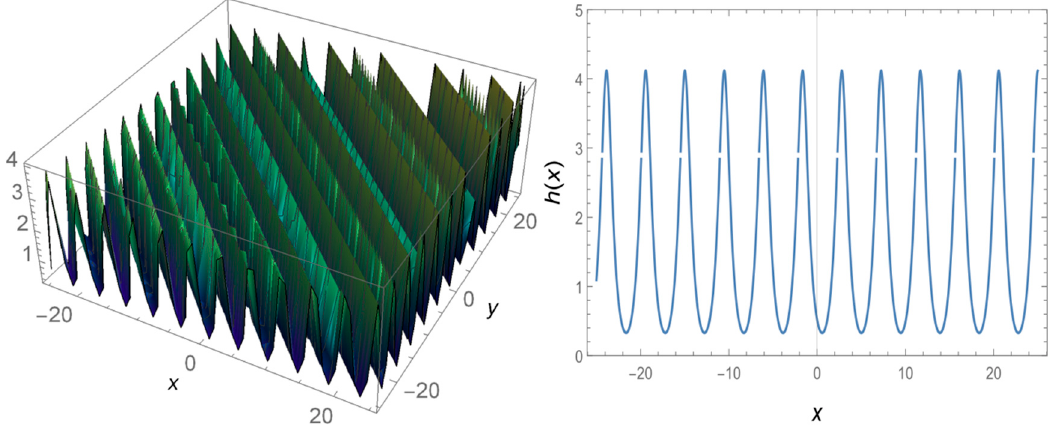
Figure 4. Three-dimensional and 2D graphs for values t = 2, θ 0 = 1, λ = 3, m = 2, µ = 0.5, d = 1, ρ = 1, τ = 1, b = − 1, (cid:36) = 1 of Equation (21) and y = 2 for 2D.